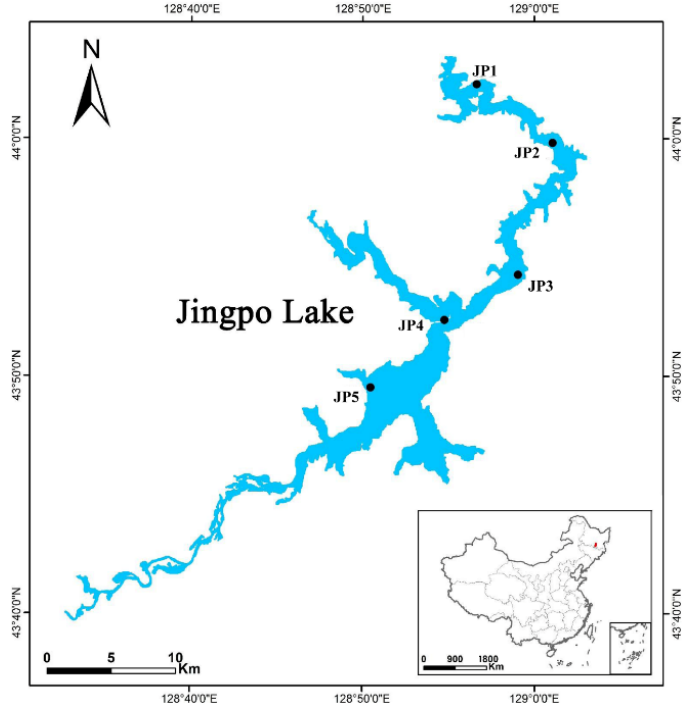
Figure 1. Sampling sites of Jingpo Lake.